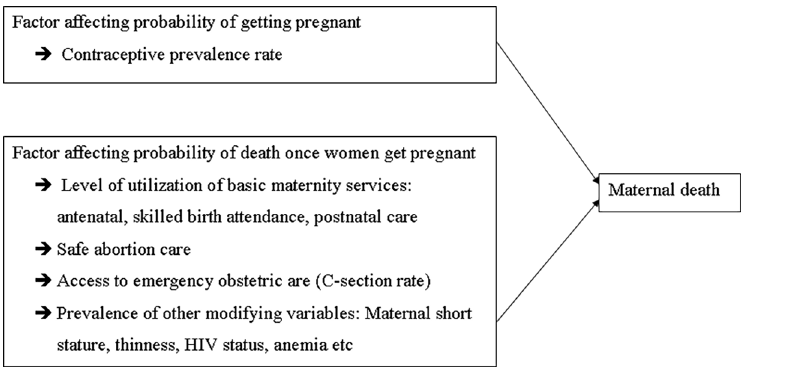
Fig 2. Conceptual framework of the